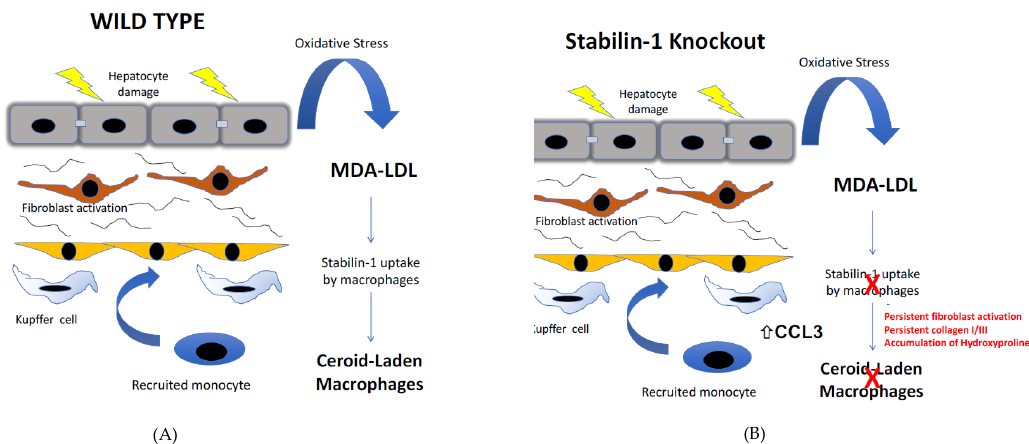
Figure 5. Stabilin-1 expression on hepatic macrophages protects against excessive tissue damage from chronic oxidative stress. ( A ) In models of chronic liver injury, the repetitive damage to hepatocytes leads to oxidative stress and lipid peroxidation, which leads to the formation of malondialdheyde-lipoproteins (MDA-LDL), which accumulate in the liver. Stabilin-1 expression on hepatic macrophages leads to the uptake of MDA-LDL, which leads to the formation of ceroid-laden macrophages that are found at sites of scarring. The active uptake of MDA-LDL by stabilin-1 positive macrophages suppresses the release of pro inflammatory mediators such as CCL3. ( B ) In the setting of stabilin-1 deficiency, there is a loss of these ceroid-laden macrophages and a lack of accumulation of MDA-LDL within hepatic macrophages. The stabilin-1-deficient hepatic macrophages are shifted to a pro-inflammatory phenotype including excessive release of CCL3, and this is associated with excessive scarring from activated liver fibroblasts and delayed healing after liver